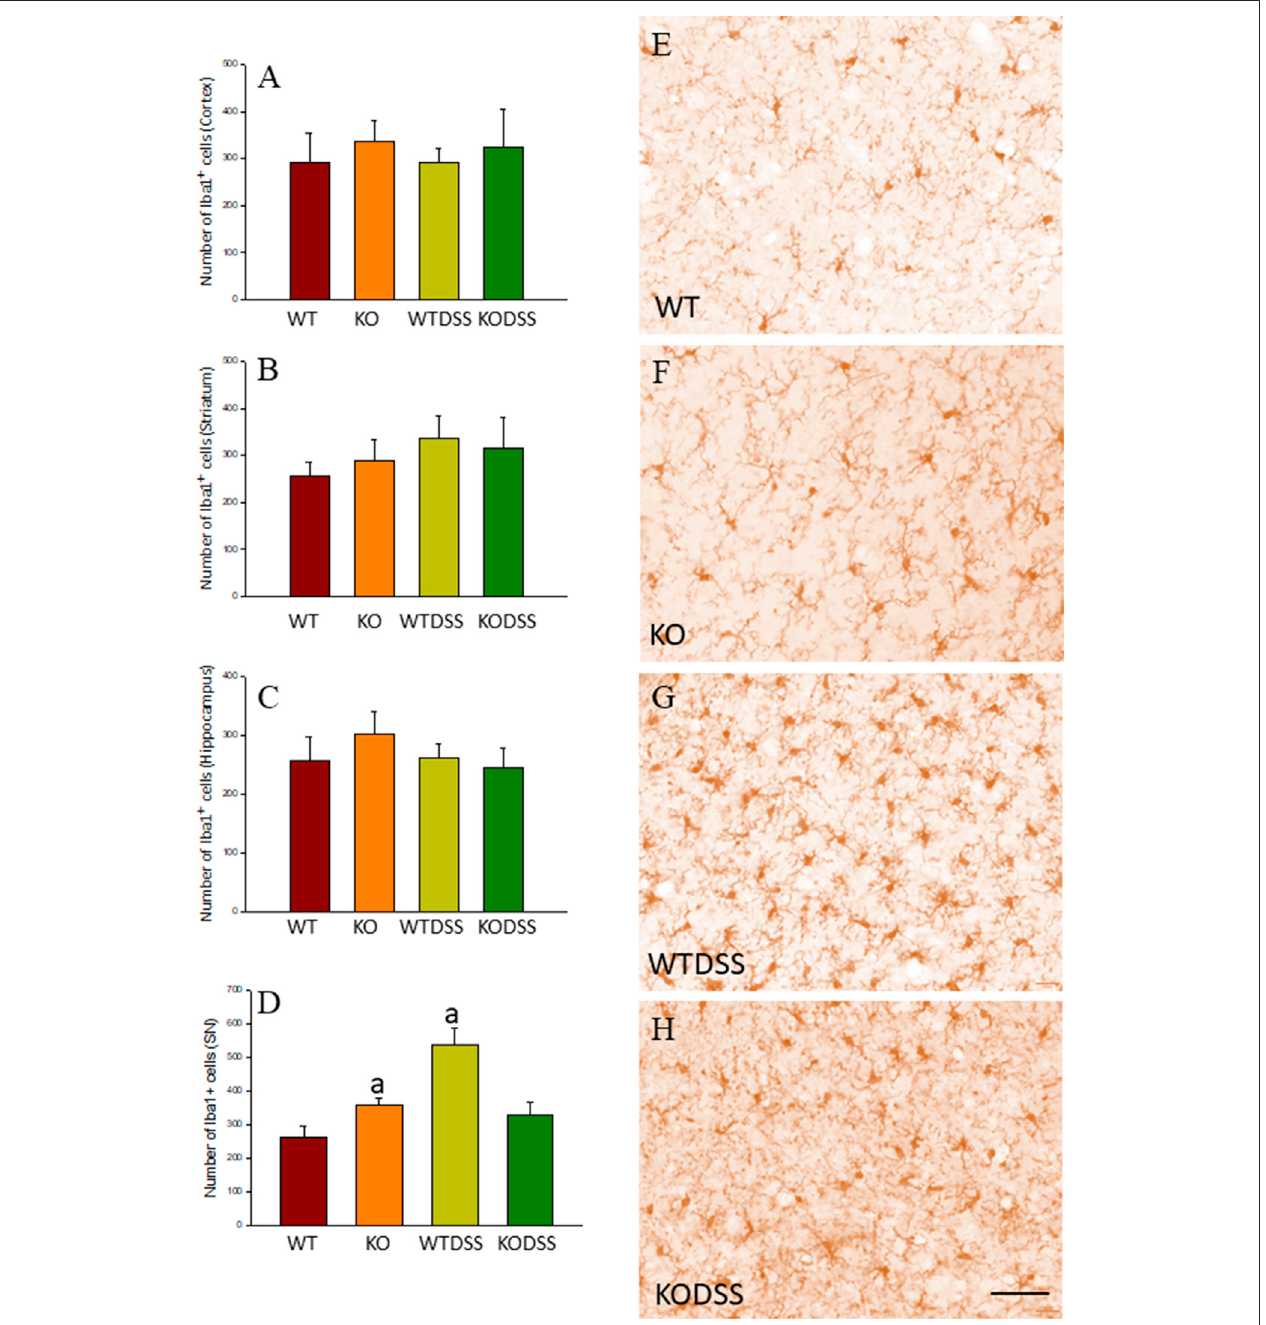
FIGURE8| EvaluationofthemicroglialactivationinducedbyDSStreatmentinWTandGal3KOmice.Theeffectofperipheralin fl ammationinducedafter10 daysof DSS treatment was evaluated in cortex (A) , striatum (B) , hippocampus (C) and SN (D) from WT and Gal3KO mice. Results are mean ± SD of at least three mice per experimental group, expressed as the number of Iba1 + cells per mm 2 . Statistical signi fi cance: One-way ANOVA followed by the Fisher ’ s LSD post hoc test for multiple comparisons was used, with α (cid:2) 0.05: (a) , compared with the WT group; p < 0.001 (E – H) Representative immunostaining from SN sections of the different experimental groups. Scalebar: 20 μ m. Abbreviations: WT,wildtype mice; WTDSS,wild type mice treated withDSS; KO, Gal3 knockoutmice; KODSS, Gal3 knockout mice treated with DSS.